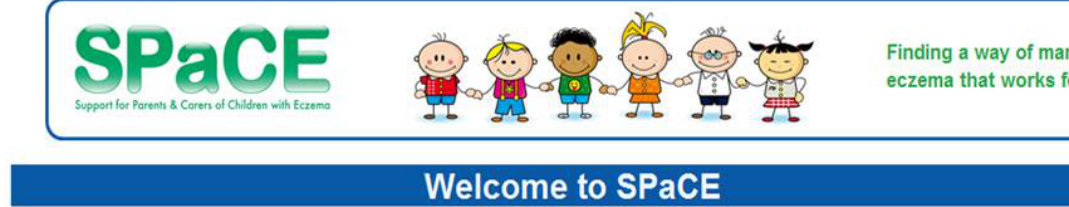
Figure 1. Screenshot of SPaCE website welcome